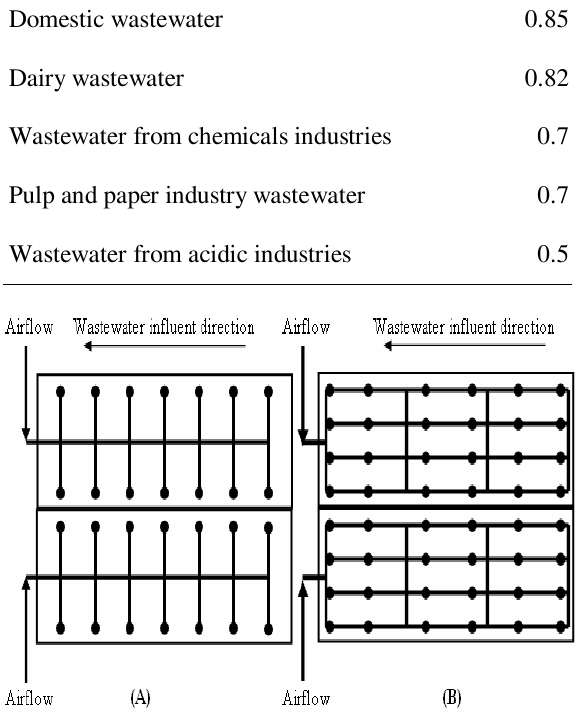
3: Two types of diffusers placement. (A): transverse arrangement. (B): longitudinal arrangement